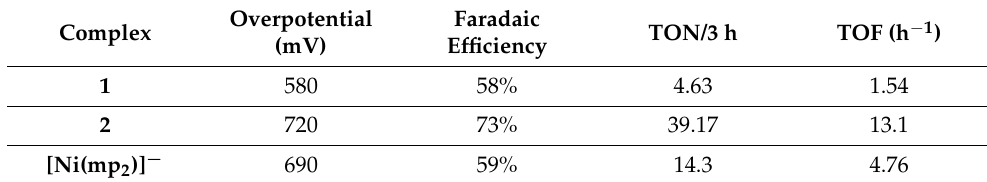
Table 2. The faradaic efficiencies at 58% and 73% for 1 and 2 , respectively, were determined at the beginning and at the end of each experiment, indicating that the catalysts were rather stable during the electrocatalytic process. The overpotential of catalysts 1 and 2 was calculated at 0.58 V and 0.72 V, respectively, based on the formula η = |(Eref-Ecat/2)| [85], where Eref stands for the reduction potential of TFA in DMF and equals to − 0.94 V [39]. Moreover, the linearity in the coulometry experiment that was performed vs. Fc/Fc + in DMF solution with 10 mM TFA indicated that catalysts were stable (Figure S9). Table 2. Bulk electrolysis experiments for H 2 evolution for complexes 1 , 2 , [Ni(mp 2 )] − . Overpotential Complex (mV)